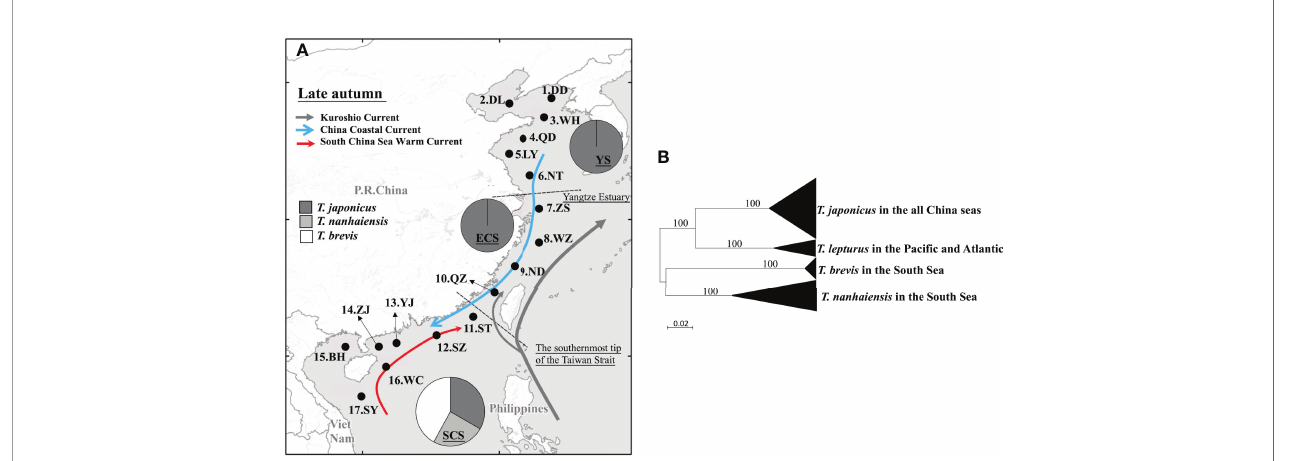
FIGURE 1 | (A) The 17 sampling localities of the genus Trichiurus along the coastal areas of the China Seas are indicated by (cid:129) . See Table 1 for the site names. The dashed lines represent the boundaries between the Yellow Sea (YS) and the East China Sea (ECS) (Yangtze Estuary), and between the ECS and the South China Sea (SCS). The pie charts represent the species composition of hairtail ( T. japonicus in dark gray, T. nanhaiensis in light gray, and T. brevis in white) in three seas. (B) The neighbor-joining (NJ) tree of these four Trichiurus species is based on the COI gene. The numbers at the nodes are bootstrap values. The sampling size (n) is indicated in